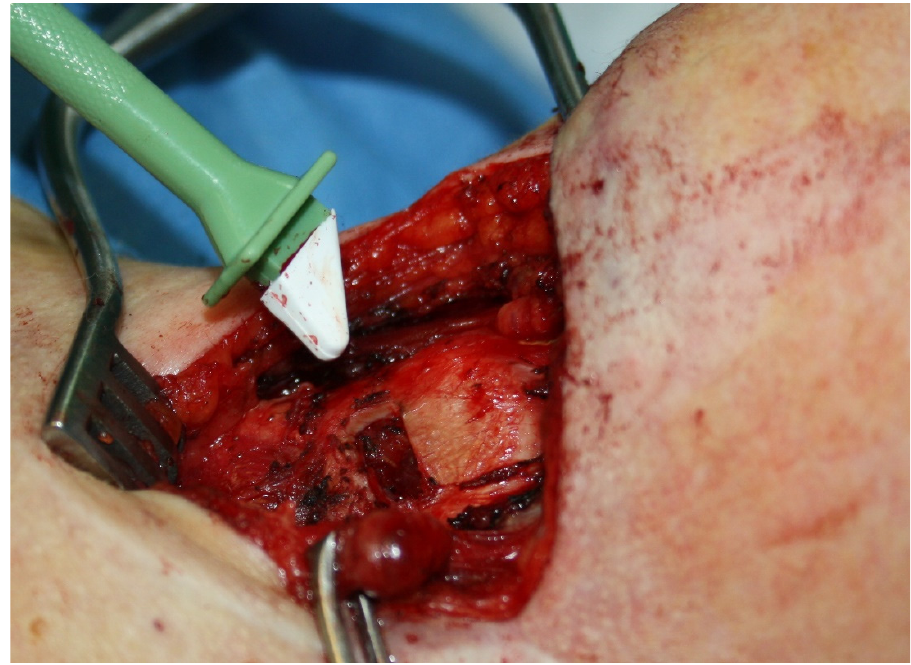
Figure 1. Meter for definitive prosthesis, inserted in the window created in the thyroid ala.